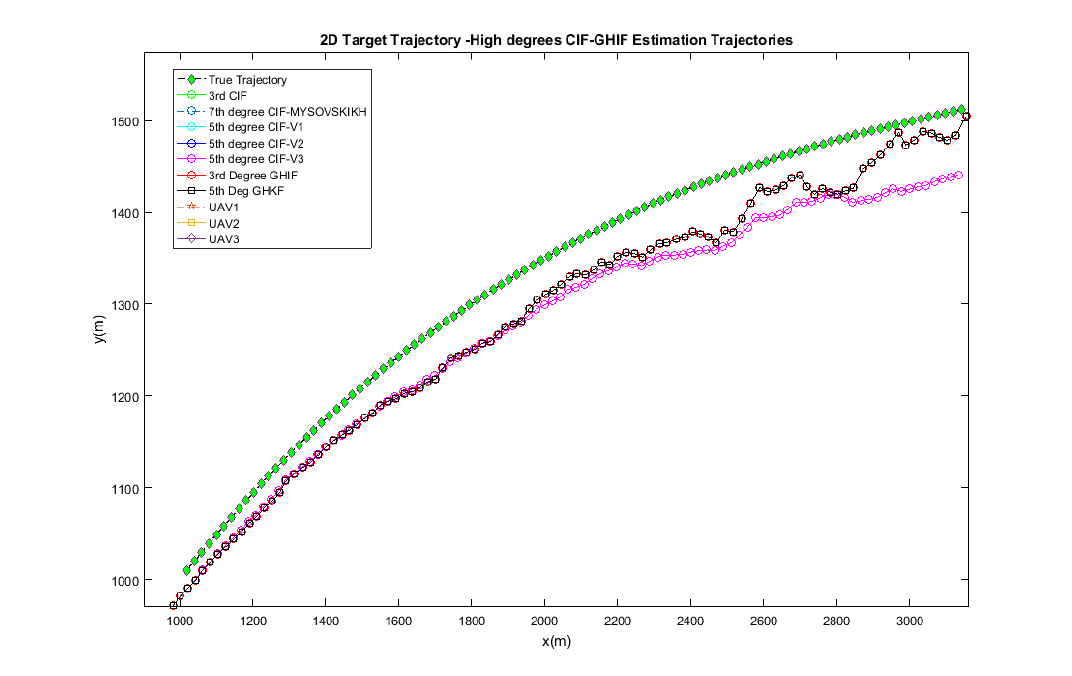
Figure 6. Range rate Doppler-based estimation: Results of 7 th -degree CIF, 5 th -degree CIF, 5 th -degree GHIF, 3 rd -degree GHIF compared to the true trajectory in green